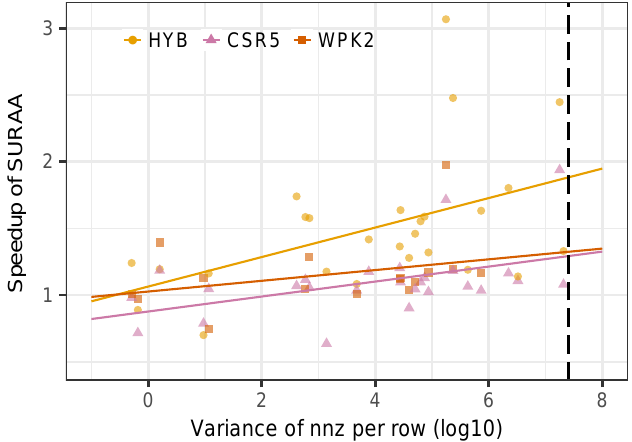
Figure 12. Speedup against the npr variance for the 26 benchmark matrices (compared for CSR5, WPK2, and